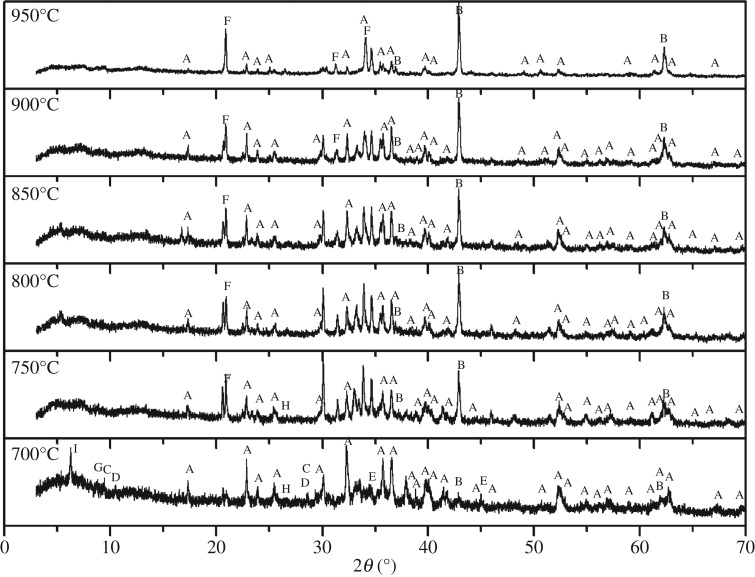
XRD patterns of samples roasted at different temperatures. (A) Mg2SiO4; (B) MgO; (C) Mg3[Si4O10](OH)2; (D) Ca2Mg5Si8O22(OH)2; (E) Mg2B2O5; (F) Na2B4O7; (G) KAl2(AlSi3O10)(OH)2; (H) SiO2; (I) Mg3[Si4O10](OH)2Mg3(OH)6.